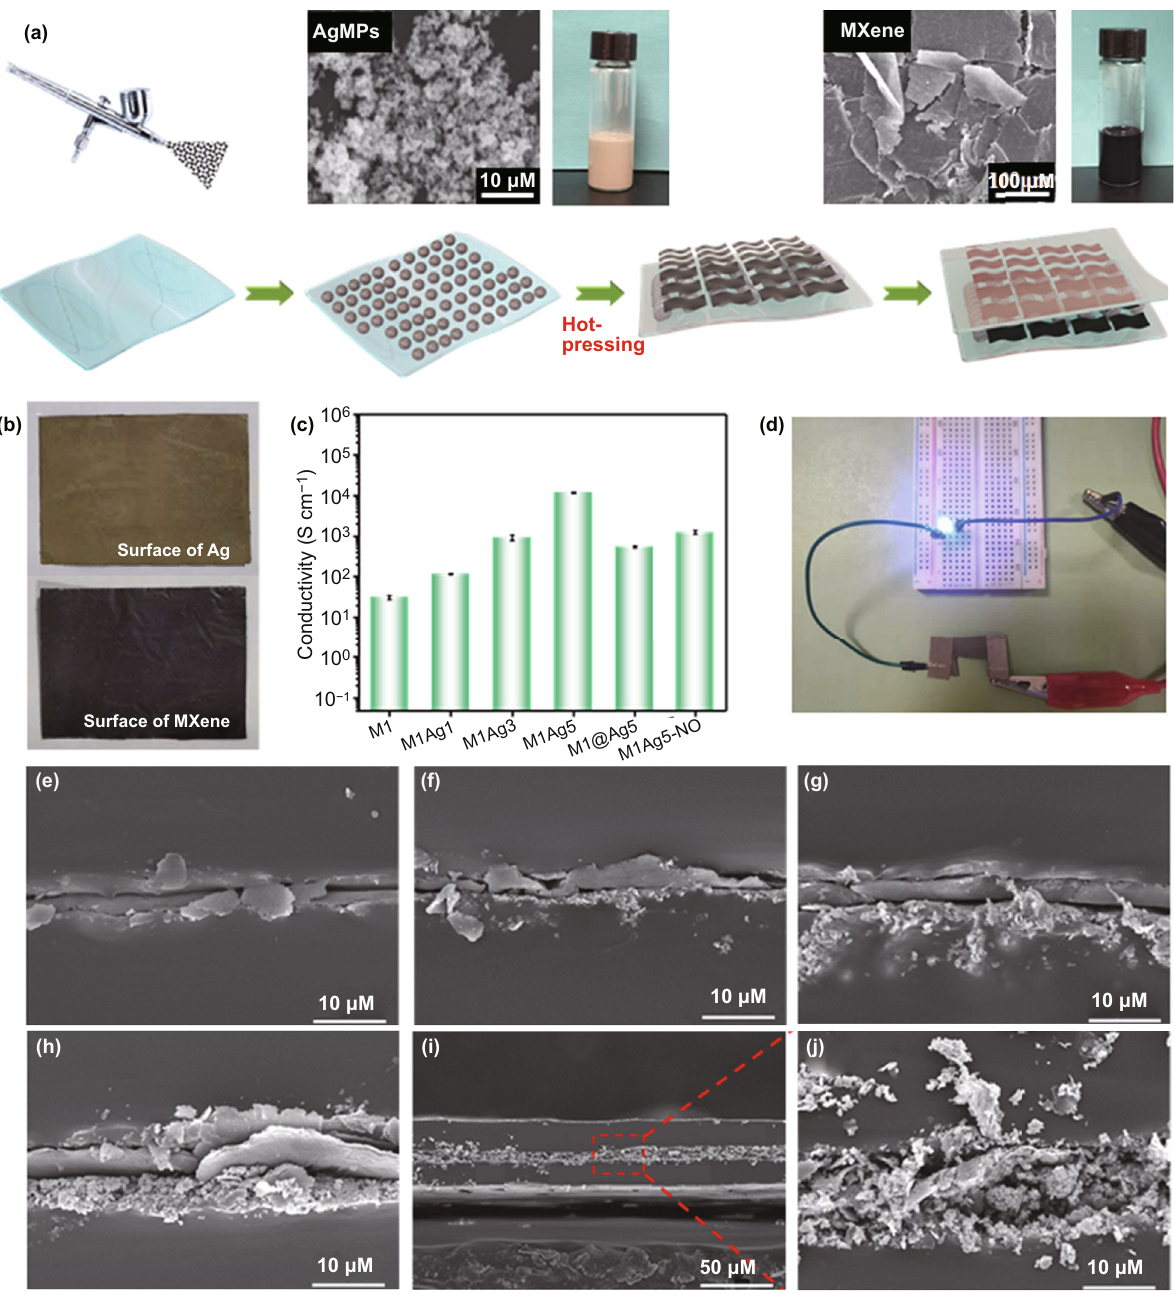
Fig. 1 a Preparation process of the EHFs. The illustrations are SEM images of AgMPs and MXene sheets as well as their dispersed solutions. b Digital photographs of both sides of EHFs. c Electrical conductivity of EHFs. d Digital photographs of lighting up LED by a power supply. Cross-sectional SEM images of e M1, f M1Ag1, g M1Ag3, h M1Ag5 and i‑j M1@Ag5